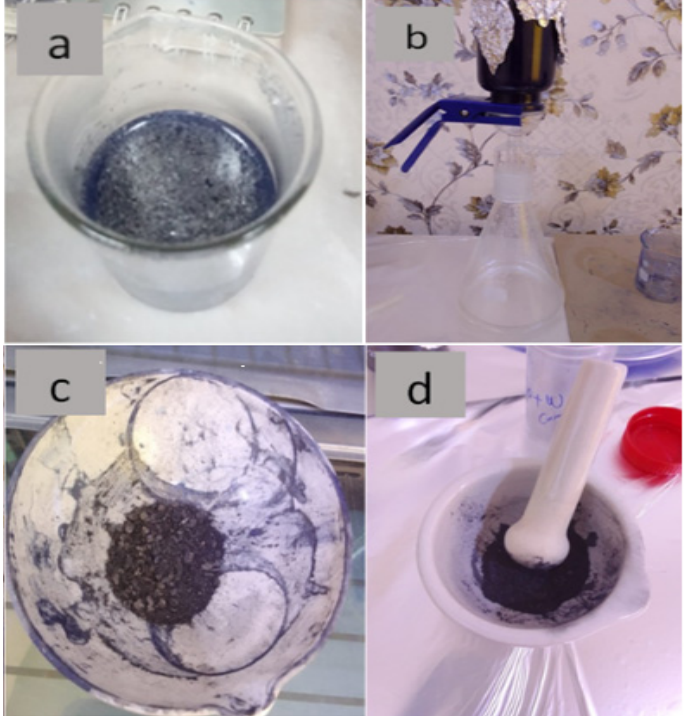
Figure 1. ( a ) GO and WO 2.89 after mixing, ( b ) vacuum nanofiltration sample, ( c ) sample after drying, ( d ) sample after grinding .